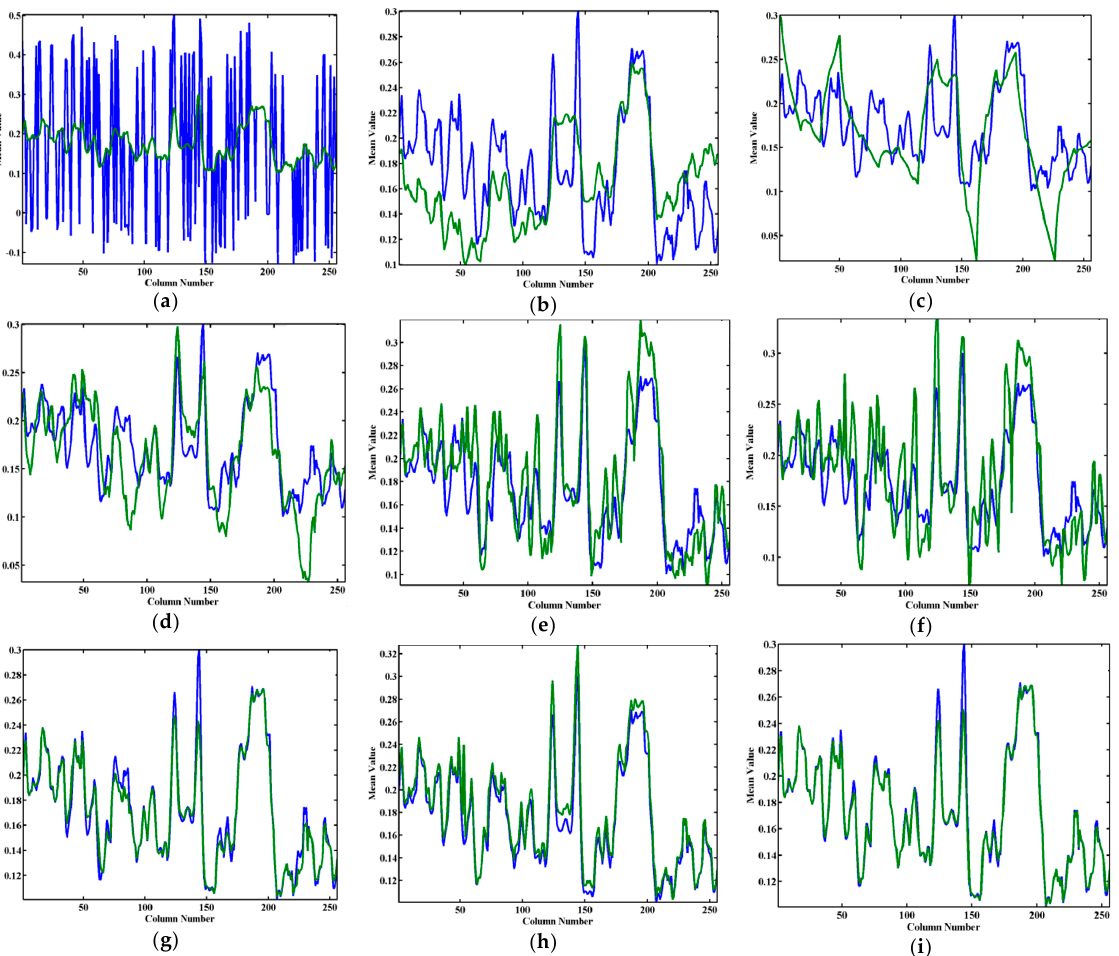
Figure 8. ( a ) Degraded with non-periodic stripes (case I = 60, r = 0.4), ( b ) UTV, ( c ) WFAF, ( d ) SGE, ( e ) ASSTV, ( f ) LRMID, ( g ) DL0S, ( h ) LRTD, and ( i ) GLTSA.